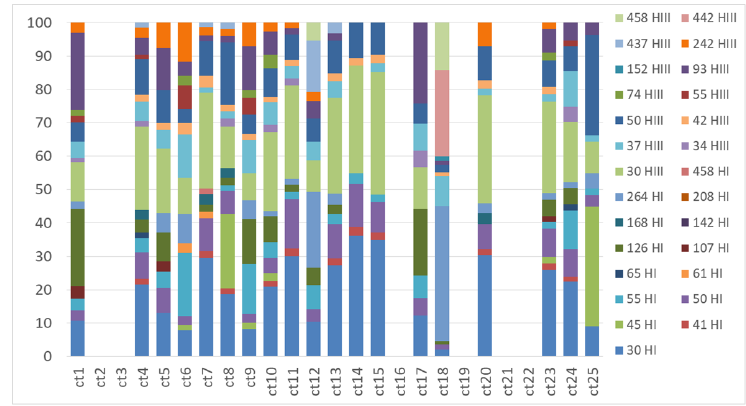
Figure A4. TRFLP profiles of the nif H gene obtained from Cladonia thallus samples with the restriction enzymes HhaI (TRFs indicated in the legend with a number followed by HI) and HaeIII (TRFs indicated in the legend with a number followed by HIII).